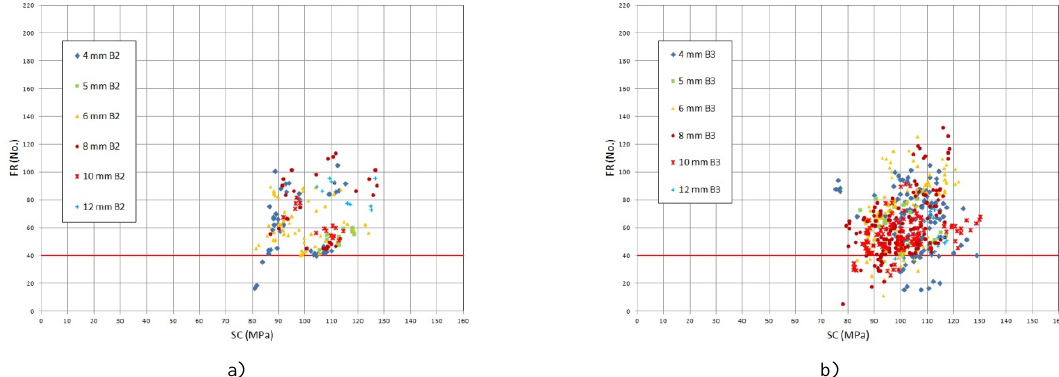
Fig. 3 Correlation of surface compressive stress (SC) versus fragmentation (FR): a) for B2 coated glass; b) for B3 coated glass